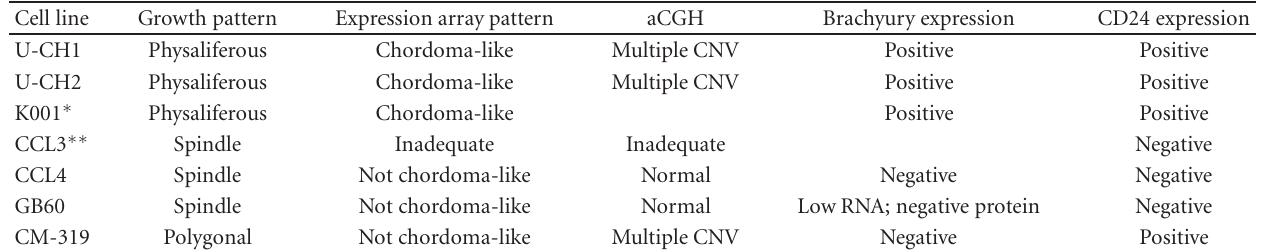
Table 2: Characteristics of cell